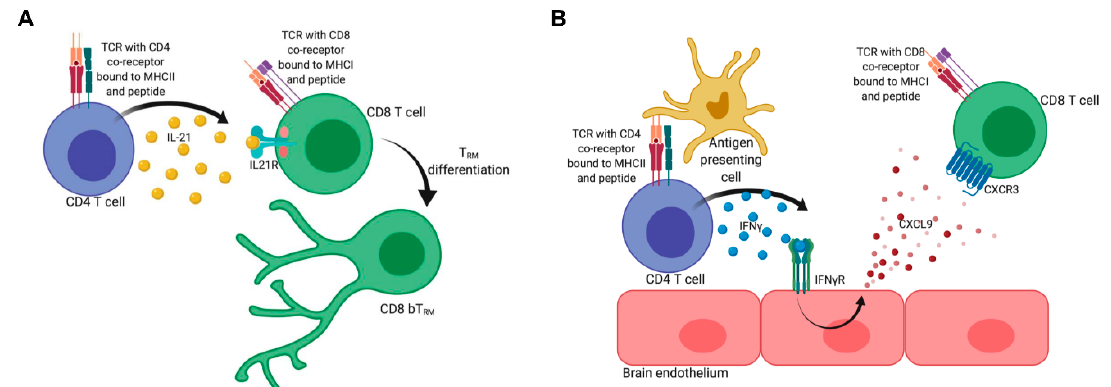
Figure 2. Potential mechanisms of CD4 T cell help in the brain. ( A ) When stimulated through their TCR, CD4 T cells produce IL-21. TCR stimulation to the CD8 T cells can upregulate their expression of IL21R. IL-21 from CD4 T cells binds IL21R on CD8 T cells to induce CD8 T RM differentiation. ( B ) CD4 T cells produce IFN γ after TCR stimulation, which binds the IFN γ R on brain endothelium to induce CXCL9 production. CXCL9 creates a gradient that CXCR3-expressing CD8 T cells follow to arrive at the site of the infection/inflammation. The figure was created with BioRender.com.